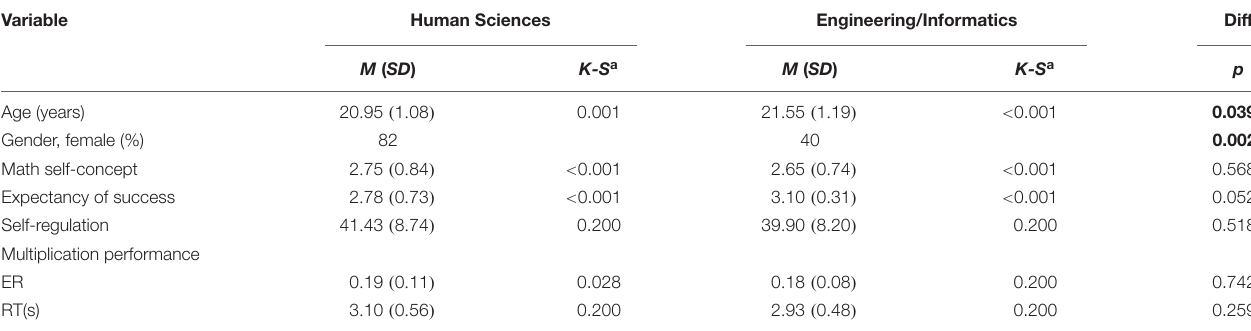
TABLE B3 | Descriptive of German students of Human Sciences and Engineering/Informatics.